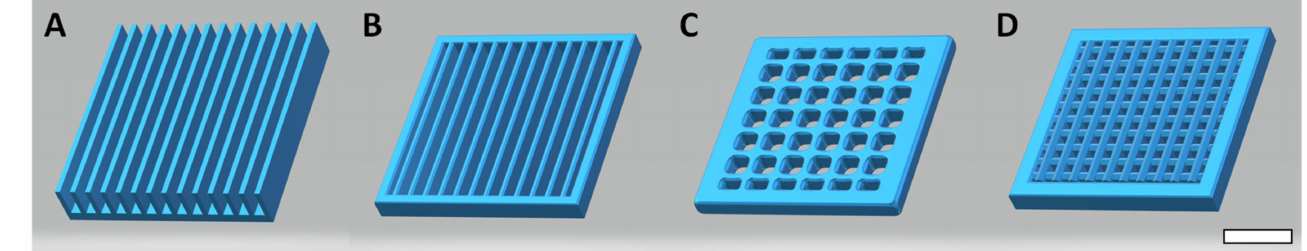
Figure 2. 3D structures modelized for printing. ( A ) Plate with vertical blades (PVB), ( B ) Grid with vertical blades (GVB), ( C ) Large mesh grid (GLM) and ( D ) Narrow mesh grid (GNM) (Scale bar = 1 cm).